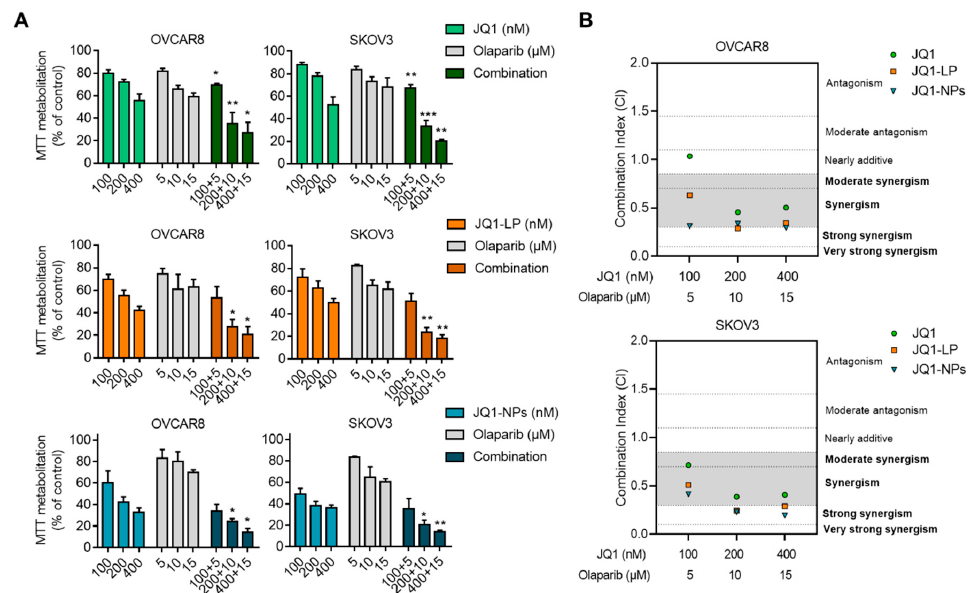
Figure 6. Evaluation of JQ1 encapsulation and olaparib combination in ovarian cell lines. ( A ) OVCAR8 and SKOV3 cell lines treated with JQ1-free (upper), JQ1-LP (middle) and JQ1-NPs (lower) alone or in combination with olaparib-free NPs for 72 h, followed by MTT assays. ( B ) Synergetic studies to evaluate the effect of JQ1-free NPs or encapsulated with olaparib-free NPs. Combination index (CI) for the different drug combinations obtained using CalcuSyn from viability values obtained in an MTT assay ( A ). CI values lower than 0.8 indicate synergistic action. * p ≤ 0.05; ** p ≤ 0.01 and *** p ≤